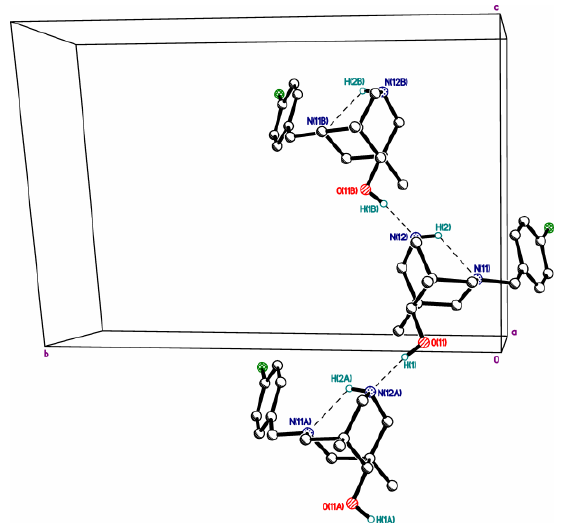
Figure 4. Hydrogen-bonded chains in structure 3c.